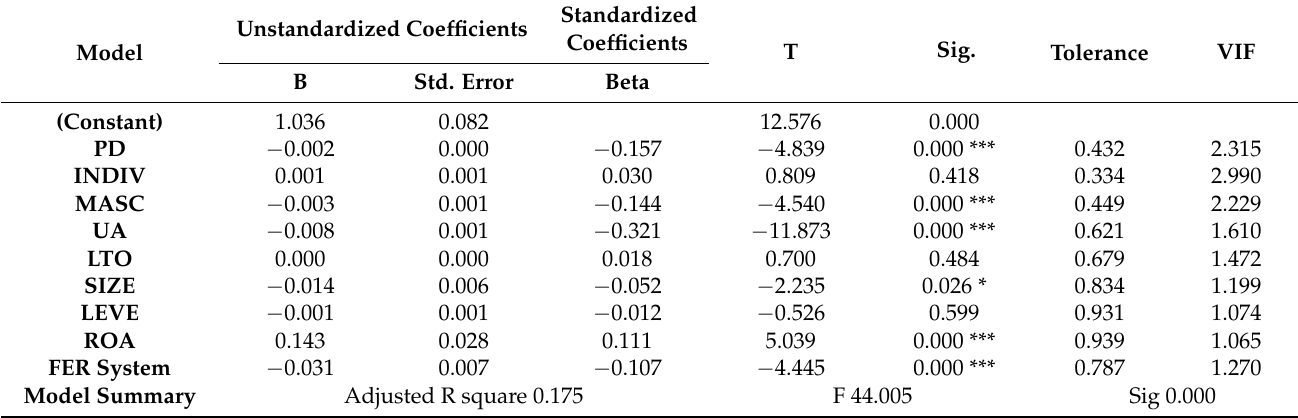
Table 8. Model 5: Impact of foreign exchange rate system on the association between culture and cash holdings.